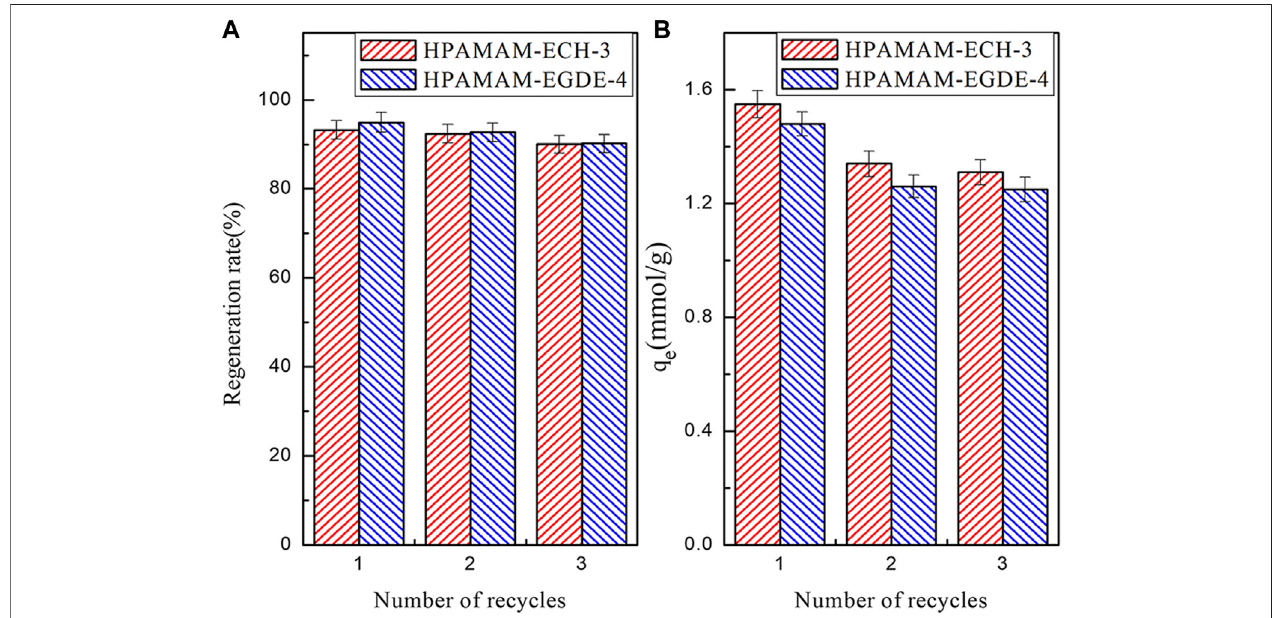
FIGURE 7 | The regeneration rate (A) and elution regeneration (B) adsorption capacity of the adsorbents.